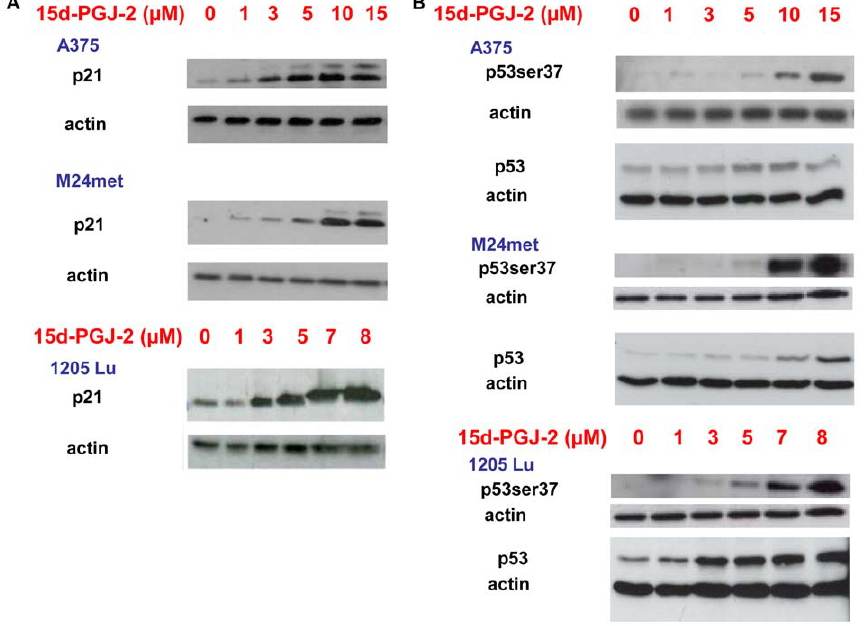
Figure 2. 15d-PGJ2 induces p21 expression and p53, p53ser37. A, 15d-PGJ2 leads to an induction of p21. Immunoblotting of p21 after 48 hours of 15d-PGJ2 treatment with indicated concentrations. B, Immunoblotting of p53 and p53ser37 after 48 hours of 15d-PGJ2 treatment with indicated concentrations.